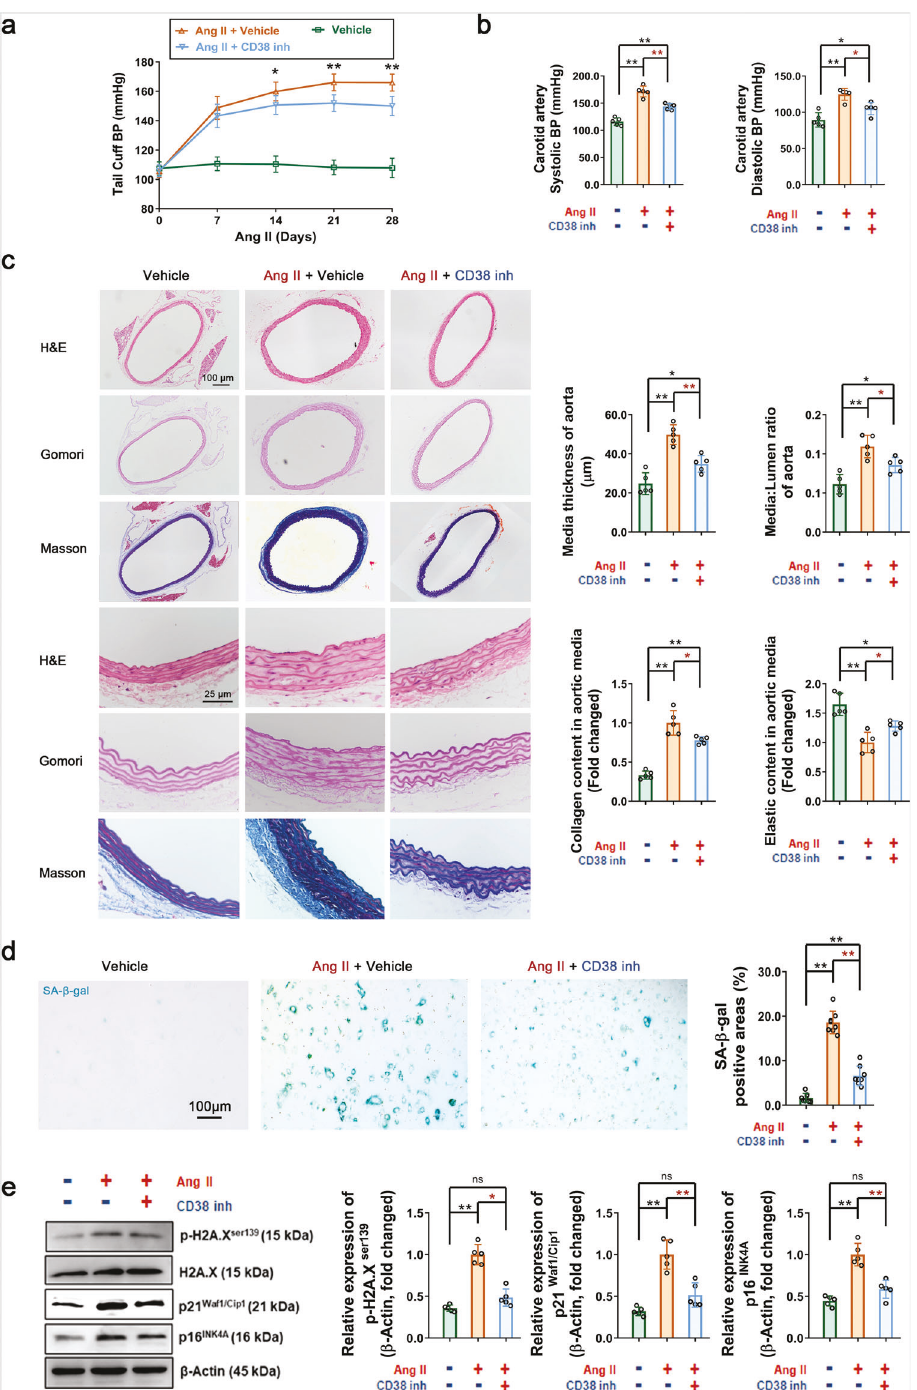
Fig. 3 Inhibition of CD38 activities alleviated Ang II-induced hypertension, vascular remodeling, and VSMC senescence. a Caudal artery blood pressures were detected in WT mice with CD38 inhibitor (inh) or Vehicle administration every 7 days after Ang II infusion ( n = 10, two-way ANOVA, * p < 0.05, ** p < 0.01). b The systolic and diastolic blood pressures of the carotid artery were detected in WT mice with CD38 inhibitor or Vehicle administration 4 weeks after Ang II infusion ( n = 10, one-way ANOVA, * p < 0.05, ** p < 0.01). c Vascular remodeling was analyzed